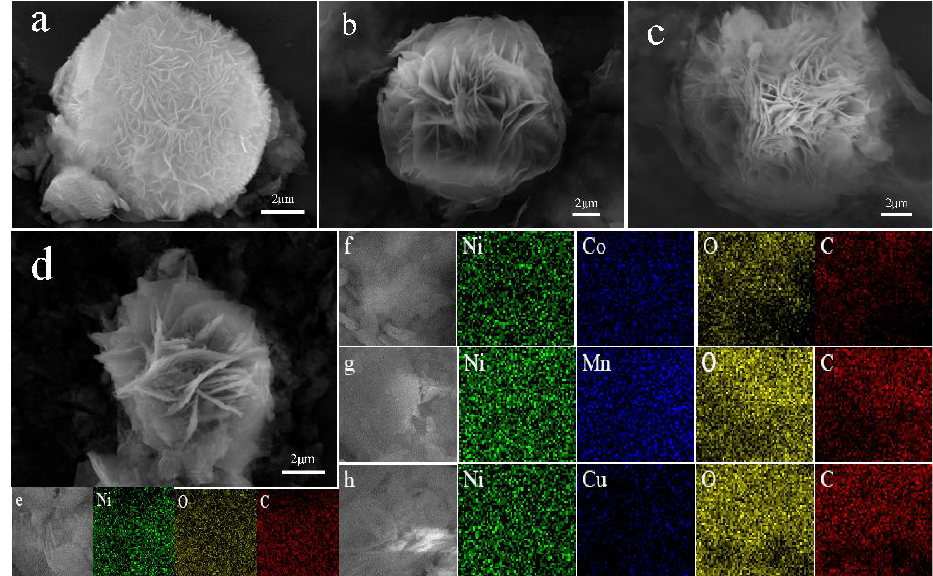
Figure 2. The SEM images of ( a ) Ni-MOFs, ( b ) NiCo-MOFs, ( c ) NiMn-MOFs, and ( d ) NiCu-MOFs; EDS elemental mapping images of ( e ) Ni-MOFs, ( f ) NiCo-MOFs, ( g ) NiMn-MOFs, and ( h ) NiCu-MOFs.